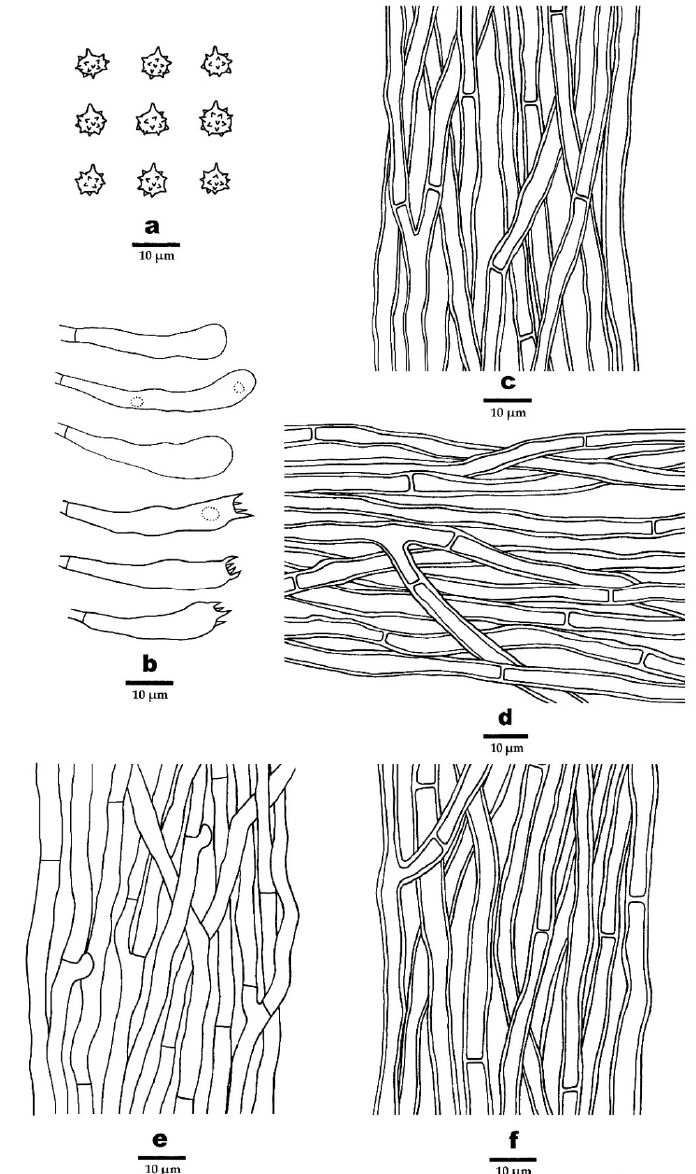
Figure 6. Microscopic structures of P. griseofuscus (drawn from the holotype). ( a ) Basidiospores, ( b ) Basidia and basidioles, ( c ) Hyphae from pileal surface, ( d ) Hyphae from context, ( e ) Hyphae from spines, and ( f ) Hyphae from stipe.